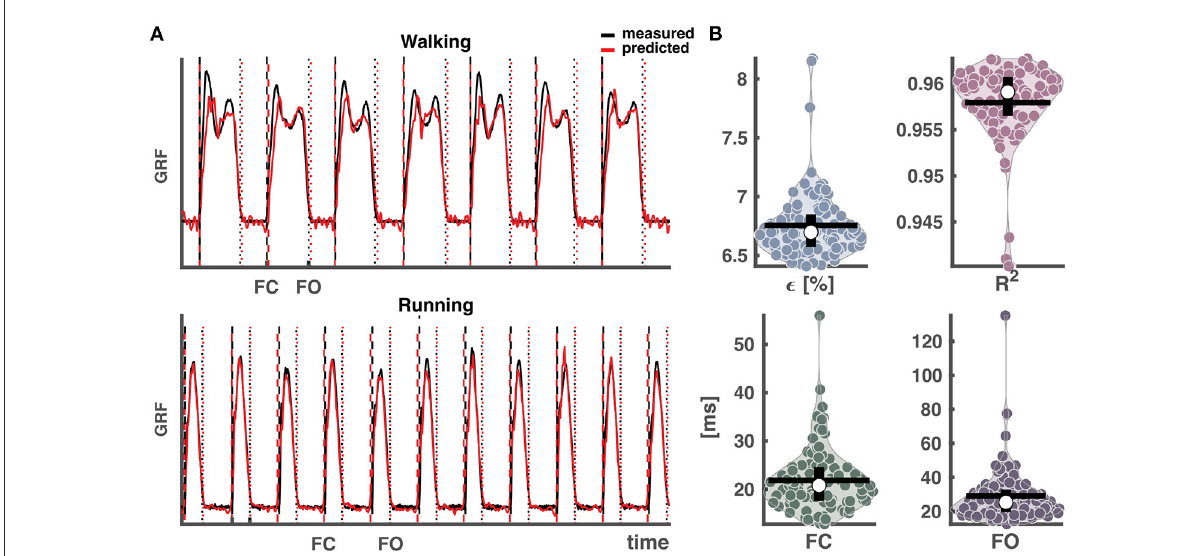
FIGURE4 Output of reservoir computer trained on segmented data and validated and tested on continuous data pooled over conditions. (A) Vertical ground reaction force (GRF) waveforms of four randomly selected strides from each condition from a random trial and a random selected training run out of the 100, with the measured vertical GRF waveforms in black and predicted in red. The vertical dashed lines represent the foot contact events (black: measured, red: predicted), the vertical dotted lines the foot off events (black: measured, red: predicted). (B) Normalized root-mean squared error ( ǫ ), coefficient of determination (R 2 ), mean absolute error of foot contact and foot off. The white dots in the violin-plots illustrate the medians. Black horizontal lines represent the mean and vertical black lines the 1st and 3rd quartiles. Every dot represents one of the 100 training runs, and the width of the violins is determined by the frequency. GRF, ground reaction forces; FC, foot contact; FO, foot